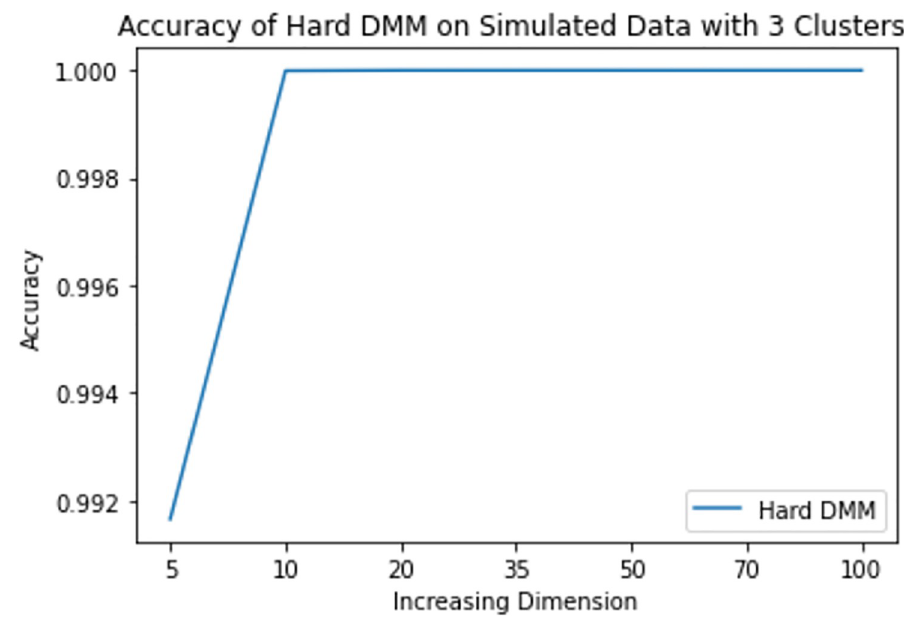
Fig 10. Mean accuracy of hard DMM 1 with 3 clusters and varied dimensions.